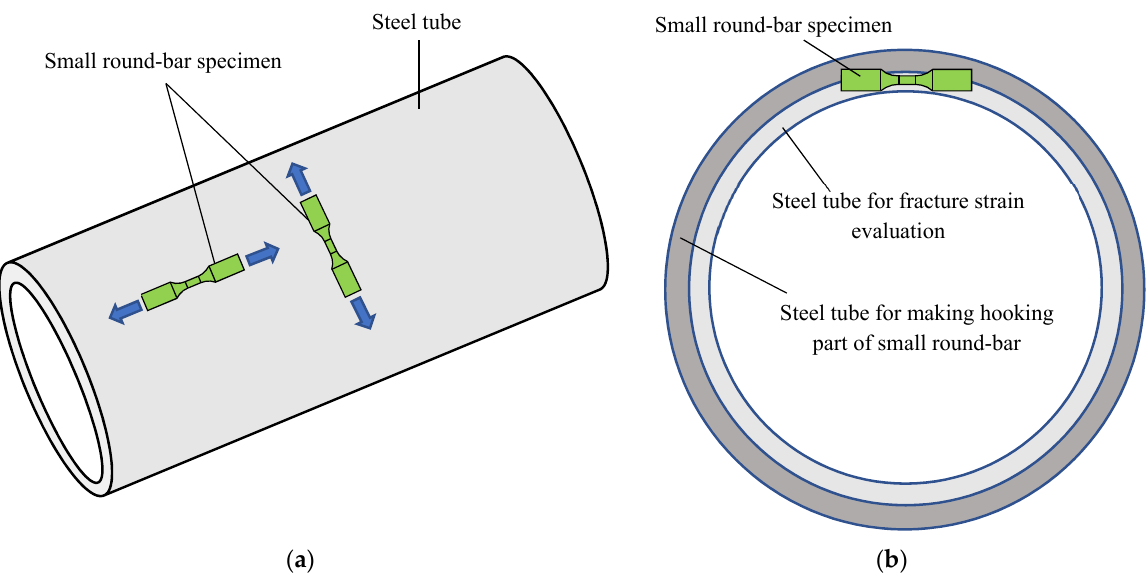
Figure 4. Image of necked and fractured small round-bar specimen after the tensile test.